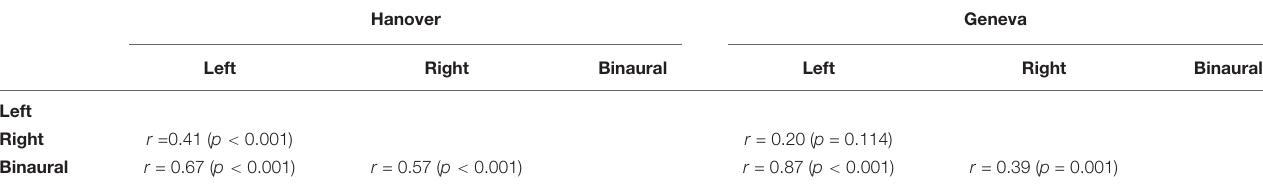
TABLE 4 | Correlation matrix of monaural and binaural conditions of SIN. Hanover Left Right Binaural Left Right